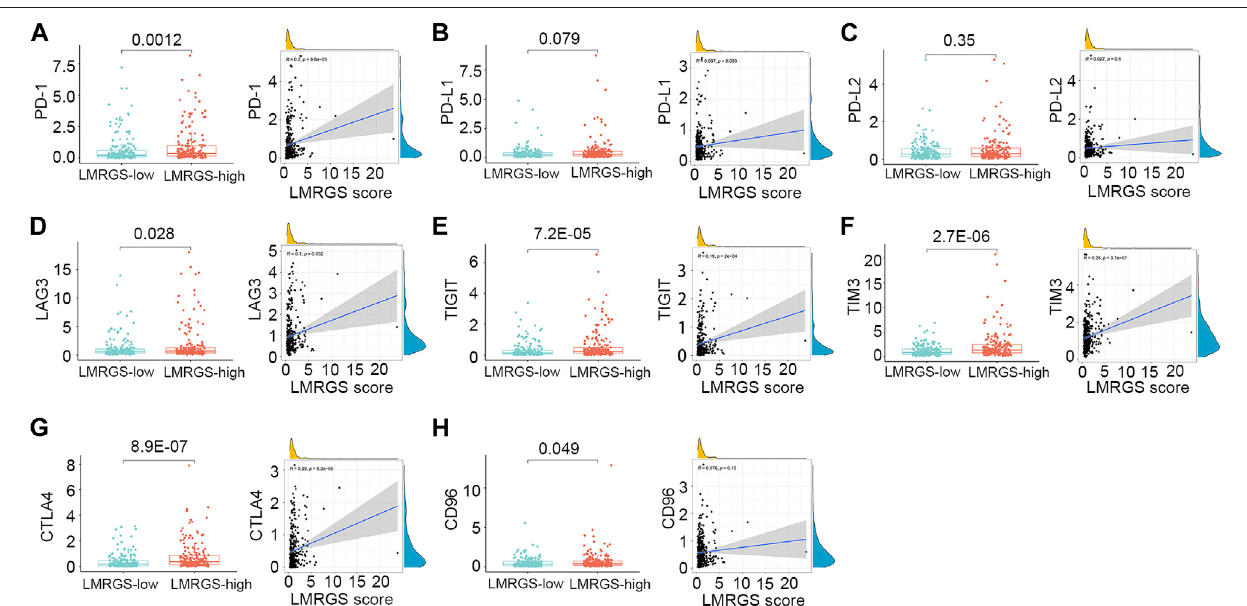
FIGURE 9 | Correlation of LMRGS score with immune checkpoints. (A) PD-1. (B) PD-L1. (C) PD-L2. (D) LAG3. (E) TIGIT. (F) TIM3. (G) CTLA4. (H) CD96.